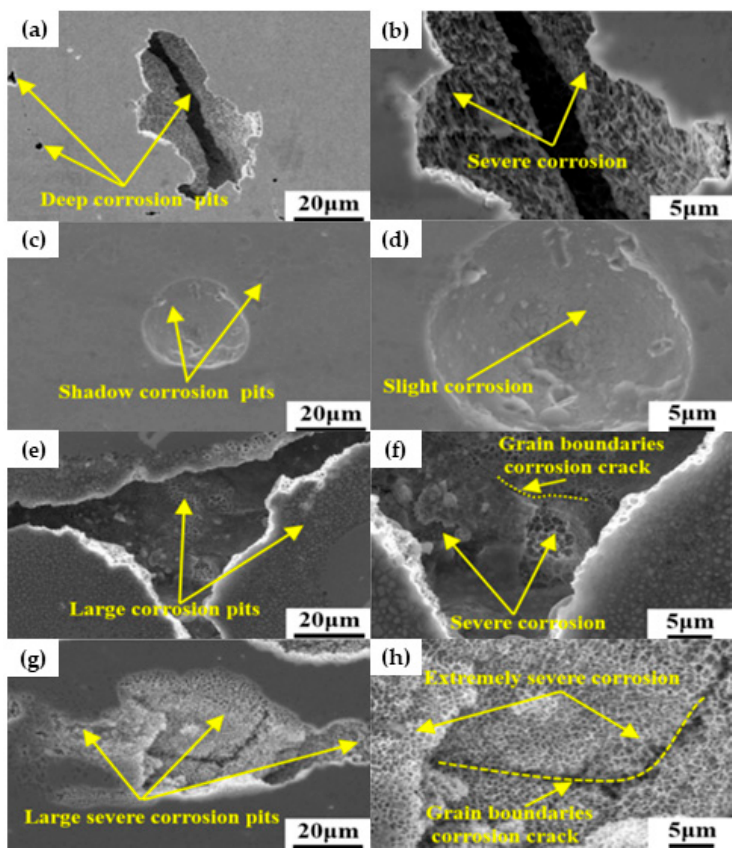
Figure 6. Surface morphology images of the SLM TiB 2 /S136 composites after corrosion tests in the 3.5 wt.% NaCl solution: ( a , b ) pure S136; ( c , d ) 0.5 wt.% TiB 2 ; ( e , f ) 1.5 wt.% TiB 2 ; ( g , h ) 2.5 wt.% TiB 2 . The low magnification is on the left, and the high magnification is on the right [49].